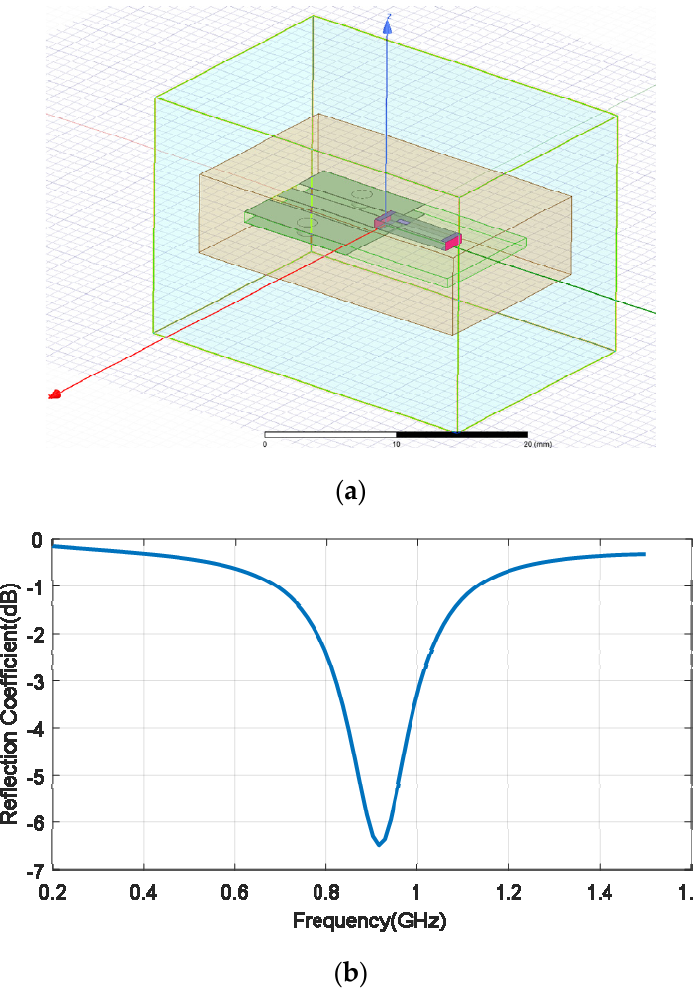
Figure 8. ( a ) Image of the simulated antenna with HFSS (high-frequency structure simulator), ( b ) simulated antenna reflection coefficient as a function of the frequency for the antenna with a 1-mm thick silicone coating.